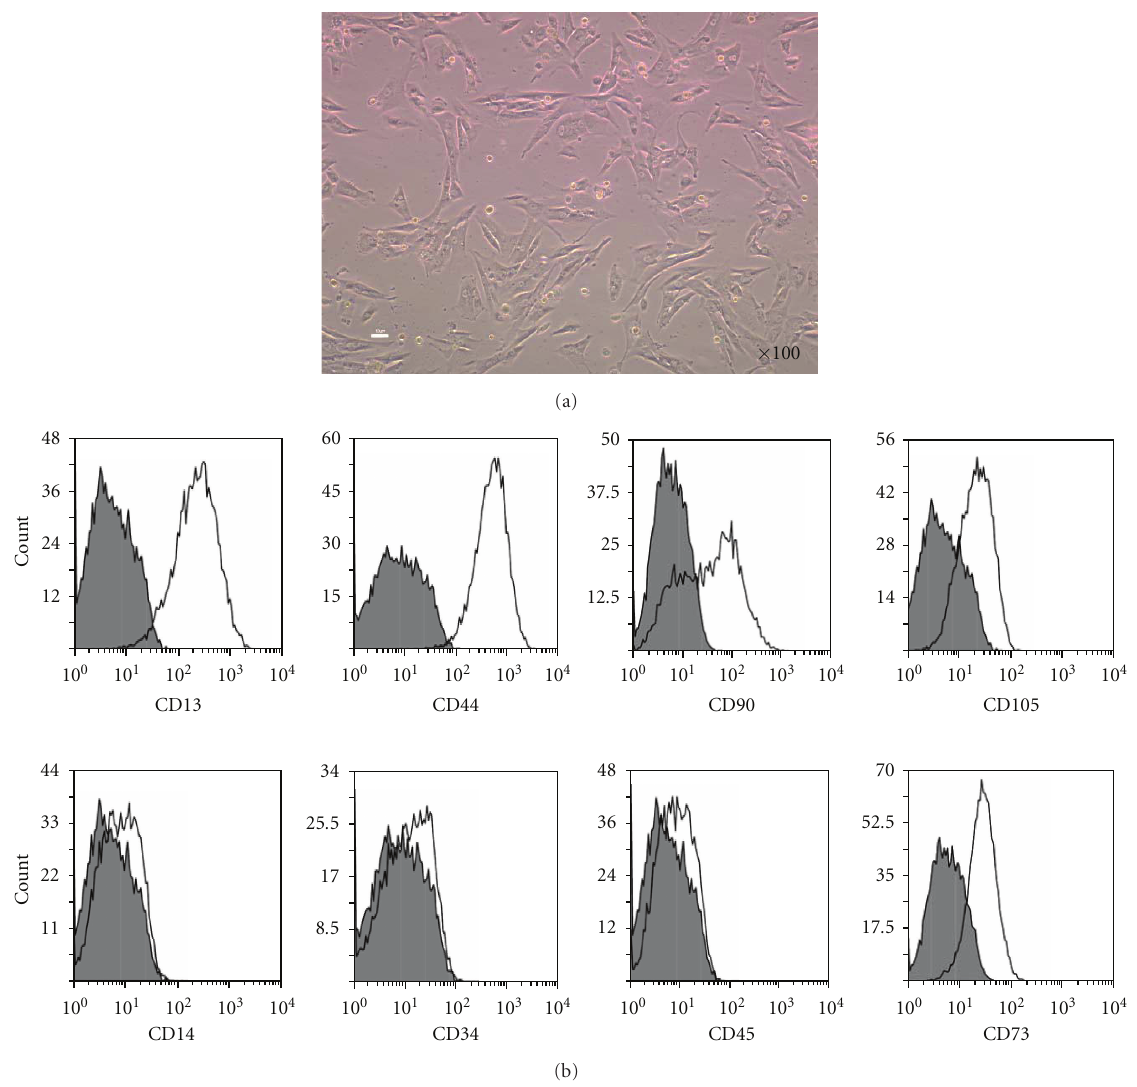
Figure 1: Morphological and flow cytometric characterization of primary human mesenchymal stem cells (hMSCs). (a) Morphology of primary human umbilical cord blood-derived MSC cultured in normal growth medium. hMSCs at passages 8-9 have a fibroblast-like morphology. × 100. (b) Immunophenotyping results of human umbilical cord blood-derived MSCs. Cells at passages 8-9 were stained with antibodies listed in Section 2 and assayed by flow cytometry. The cells were strongly positive for MSC-specific markers, such as CD13, CD44, CD73, CD90, and CD105, while negative for the hematopoietic stem cell markers CD14, CD34, and CD45. Staining for nonspecific immunoglobulin G (IgG) isotype fluorescence used as a control is represented by gray